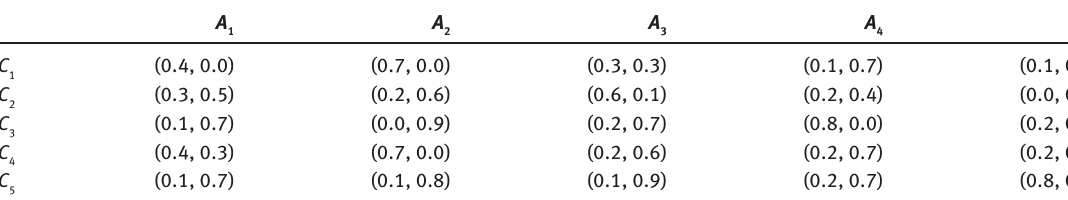
Table 1: Symptoms Characteristic for the Considered